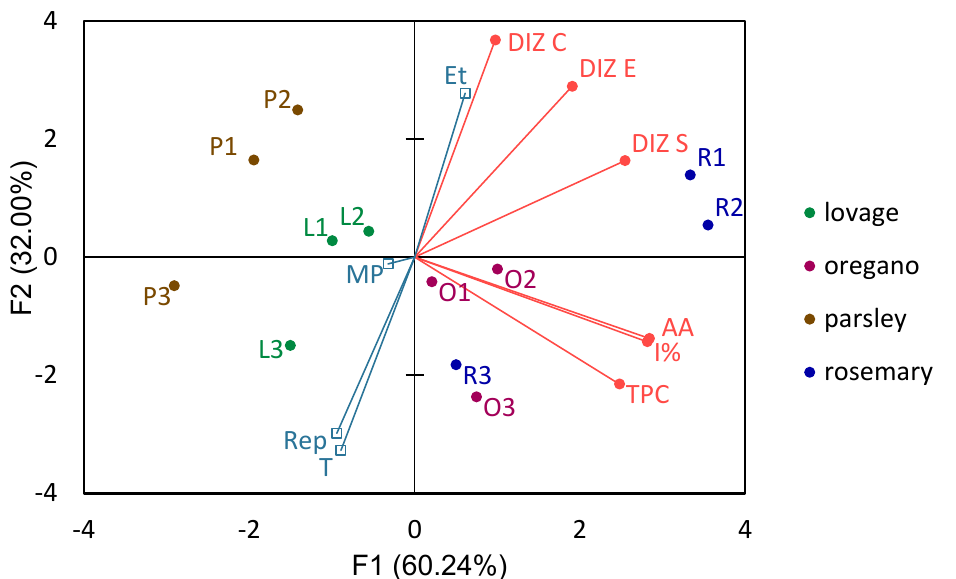
Figure 1. Principal component analysis (PCA) biplots of the samples and analyzed parameters of ethanolic extracts (axes F1 and F2: 92.24%), where R—rosemary; O—oregano; L—lovage; P—pars- ley; 1, 2, and 3—sample number according to the extraction procedure (Table 1); TPC—total phe-